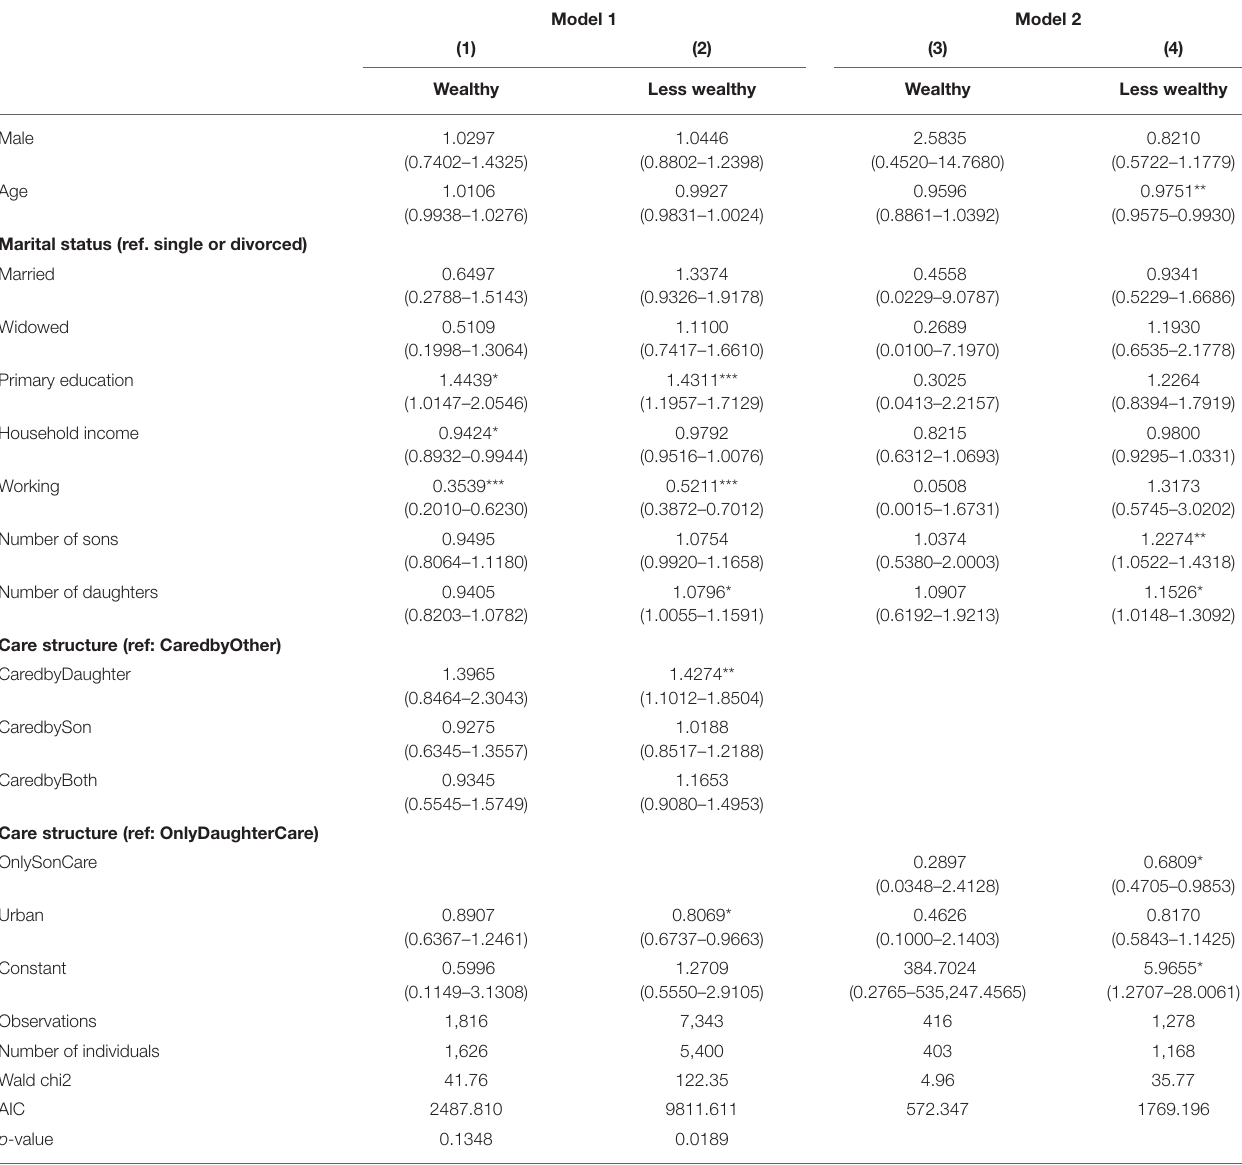
TABLE 6 | Radom-effects logistic regression models for self-reported health and care provided by son and daughter: differentiating by